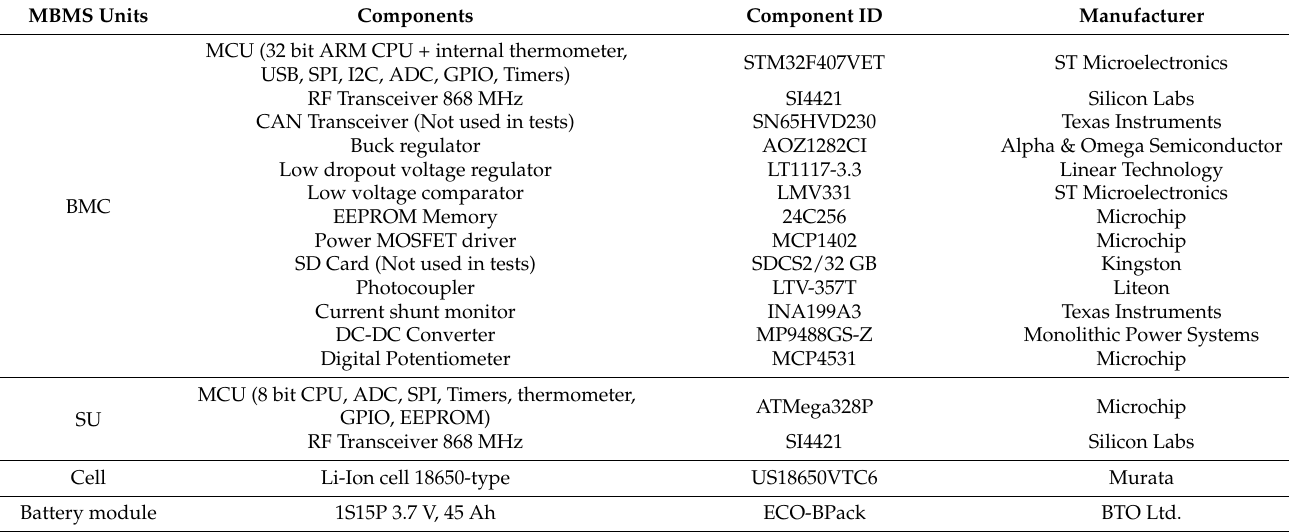
Table 1. MBMS and battery module technical specification.